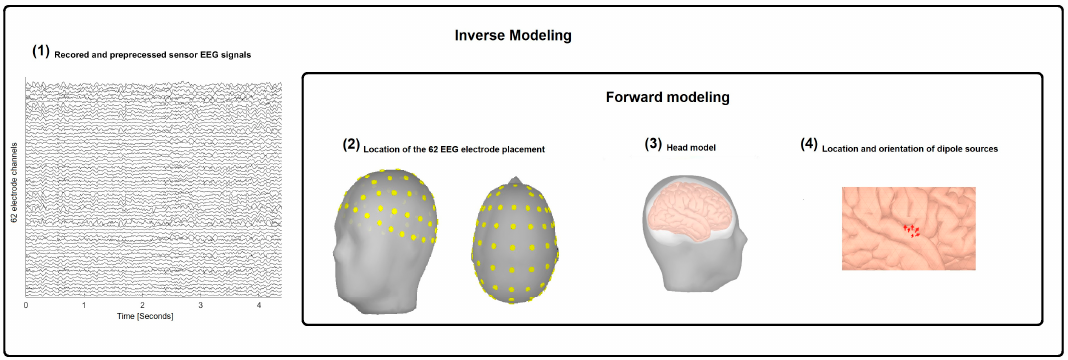
Figure 3. Illustration of the four essential pieces of information needed to do EEG source reconstruction. ( 1 ) Illustrating the EEG sensor time series, ( 2 ) the electrode placement, ( 3 ) the head model, ( 4 ) dipoles location and orientation.